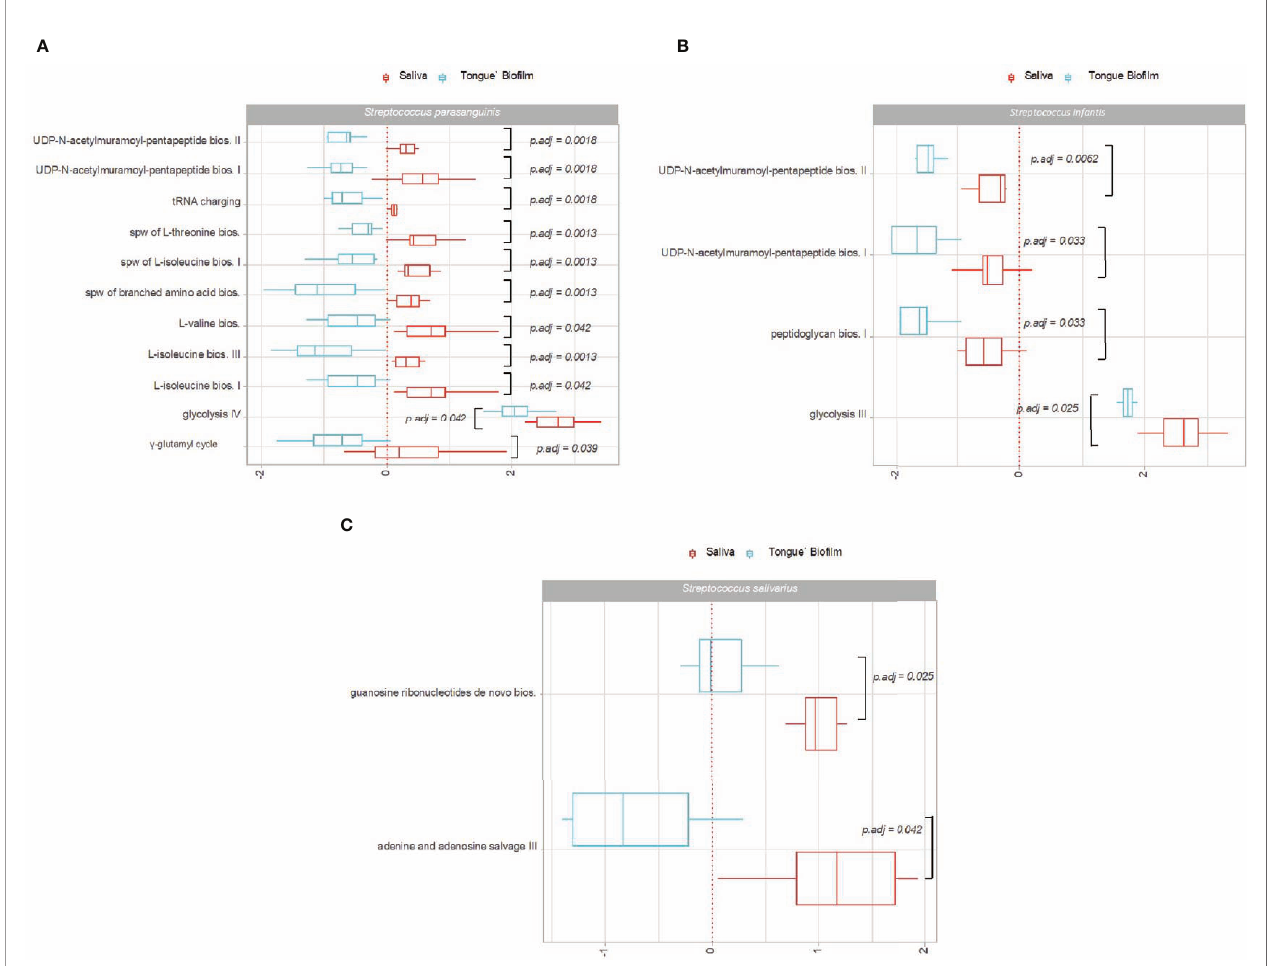
FIGURE 3 | Pathway expression of predominant Streptococcus species in saliva versus tongue bio fi lm. Pathways identi fi ed with signi fi cantly different log2(RNA/ DNA) in saliva versus tongue bio fi lm in oral health with each dot representing a speci fi c sample. (A) Streptococcus parasanguinis , (B) Streptococcus infantis , (C) Streptococcus salivarius . Boxplots display fi rst and third quartiles, median. Whiskers display 1.5 * IQR. Color coding: red: saliva, blue: tongue bio fi